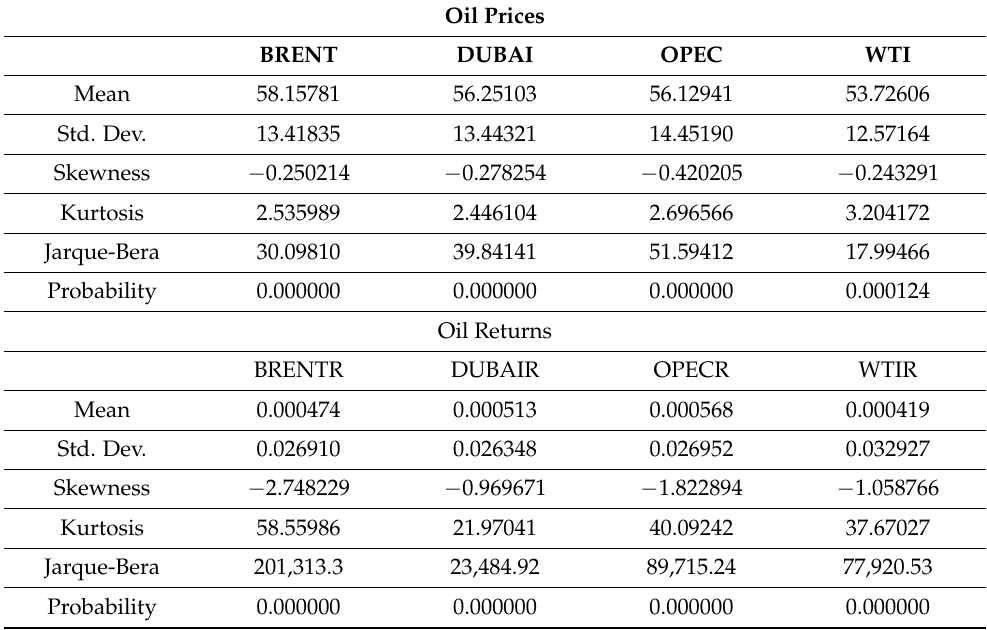
Table 4. Oil Benchmarks Descriptive